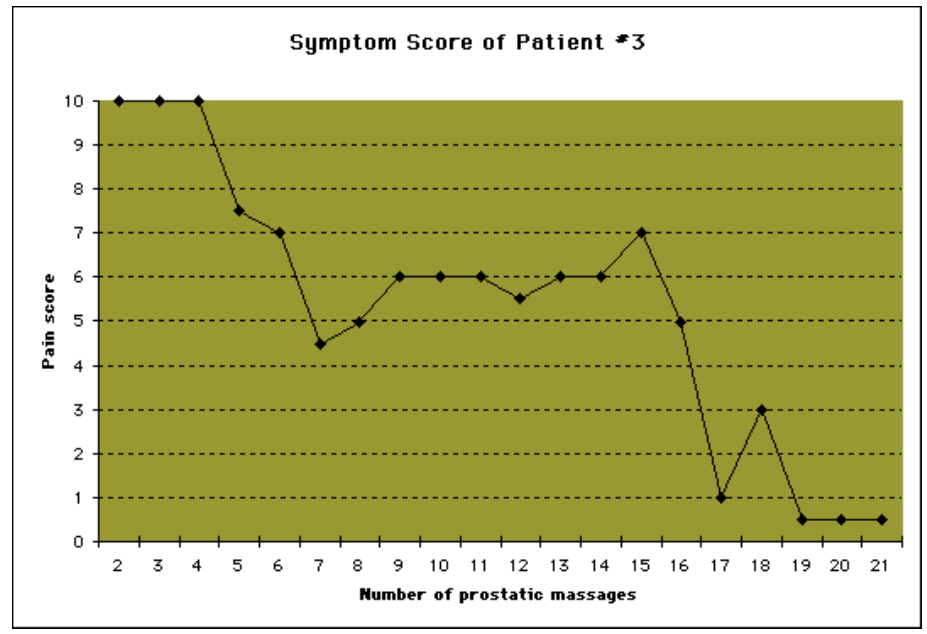
FIGURE 6 . The dropping pain score of patient #3 over 21 prostatic massages.